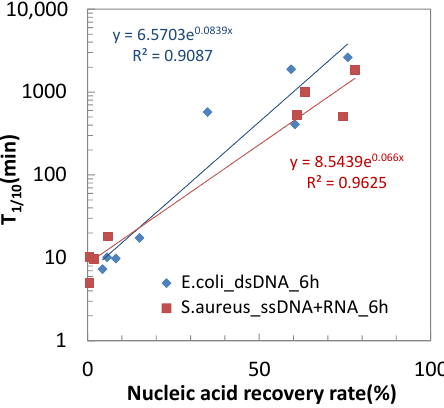
Figure 9. Correlation between nucleic acid recovery rate at 6 h and the antimicrobial activity, T 1/10